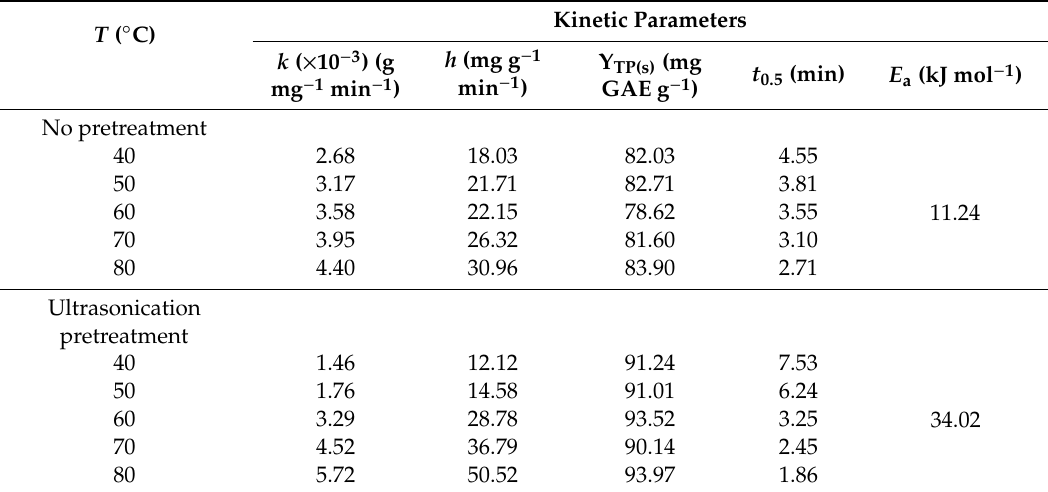
Table 6. Kinetic data and the e ff ect of